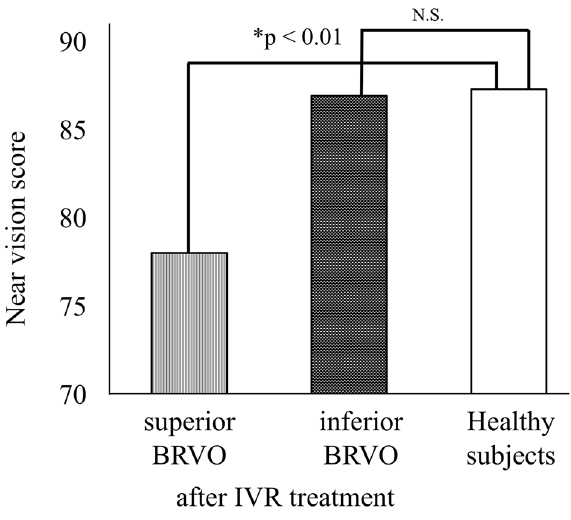
Figure 4. The near vision score in patients with superior and inferior BRVO after treatment and in healthy control subjects. *Mann–Whitney U test, N.S. not